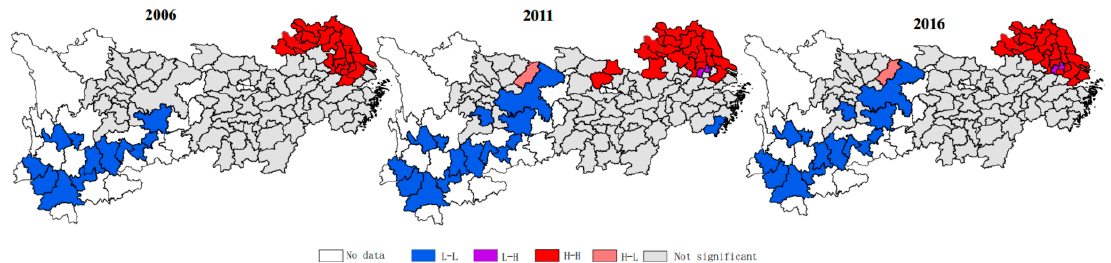
Figure 3. Scatter plot of Moran’s I values and LISA cluster map for PM 2.5 in the YREB.